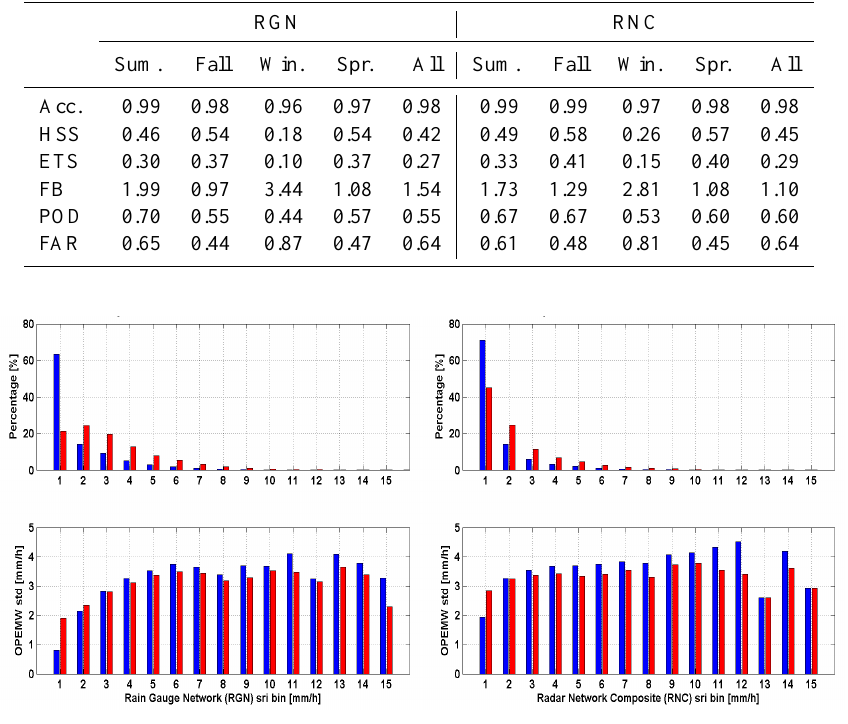
Fig. 6. Top panels: percentage histograms of binned analysis for OPEMW sri against RGN (left) and RNC (right) sri products. Bottom Figure 6: Top panels: Percentage histograms of binned analysis for OPEMW sri against RGN (left) 3 panels: standard deviation of OPEMW sri data falling into each 1mmh − 1 bin of RGN (left) and RNC (right). Blue and red bars indicate all and RNC (right) sri products. Bottom panels: Standard deviation of OPEMW sri data falling into 4 and hits-only data, each 1 mm/h bin of RGN (left) and RNC (right). Blue and red bars indicate all and hits-only data, 5 respectively. 6